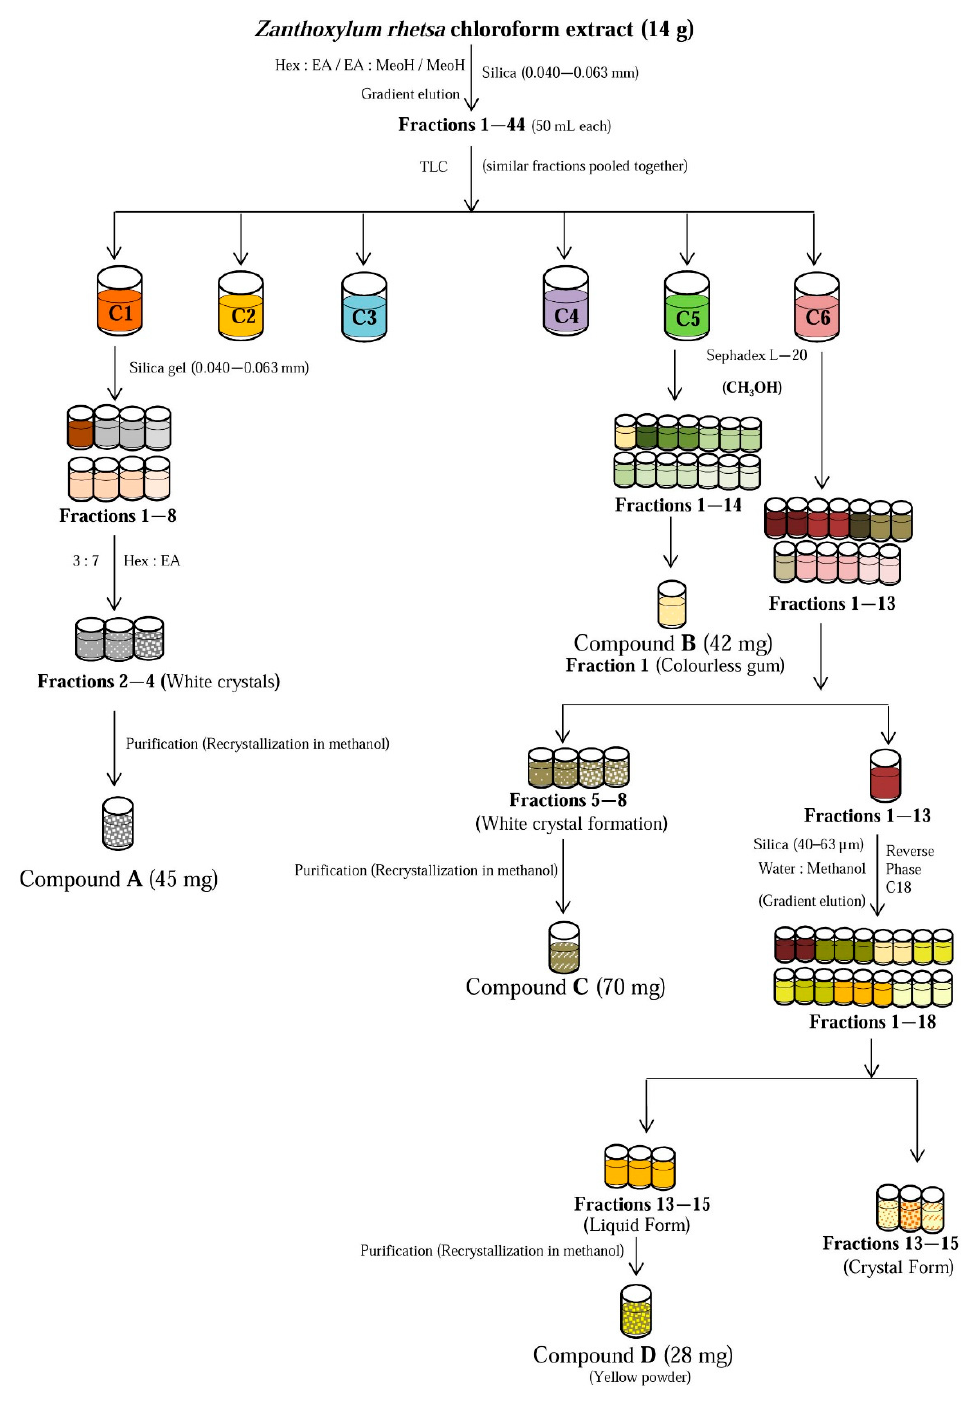
Figure 4. Isolation of compounds from the chloroform fraction of Z. rhetsa extract using column